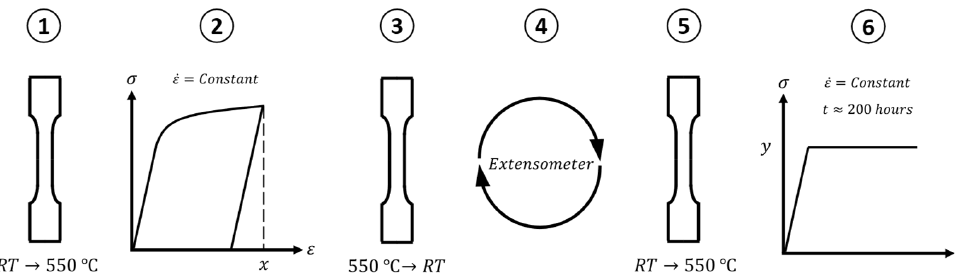
Figure 2. Summary of the experimental regime each specimen was subjected to. A more detailed description can be found in the first paragraph of Section 2.4. description can be found in the first paragraph of Section 2.4.